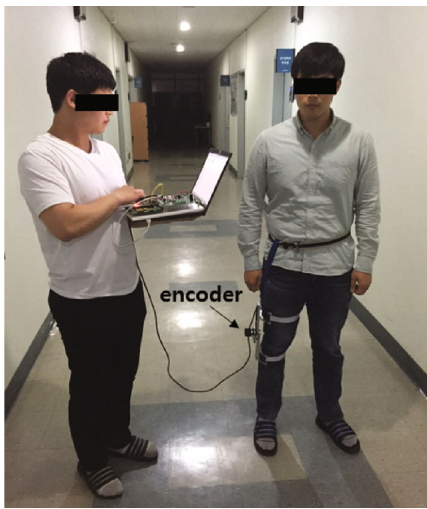
Figure 9: Measuring system of the knee motion.